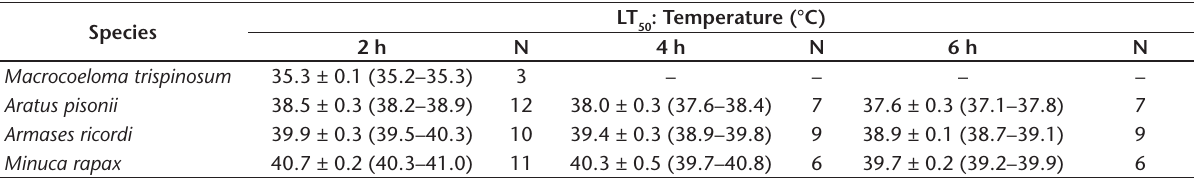
Table 1. The overall LT temperature at which 50 % of the zoea I died for the four crab species studied. Mean ± Standard deviation; N 50 = number of females.